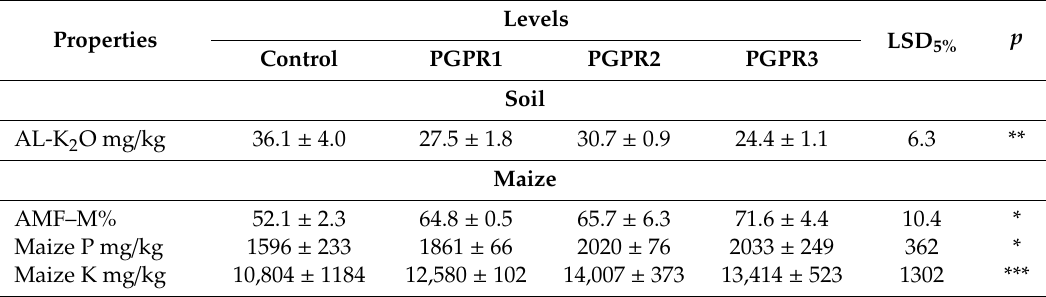
Table 5. Significant e ff ect of individual plant growth-promoting rhizobacteria (PGPR) treatment levels (colony forming units (CFU) / pot) on the properties of acidic sandy soil and maize. Data are mean ± sd of the replicates.